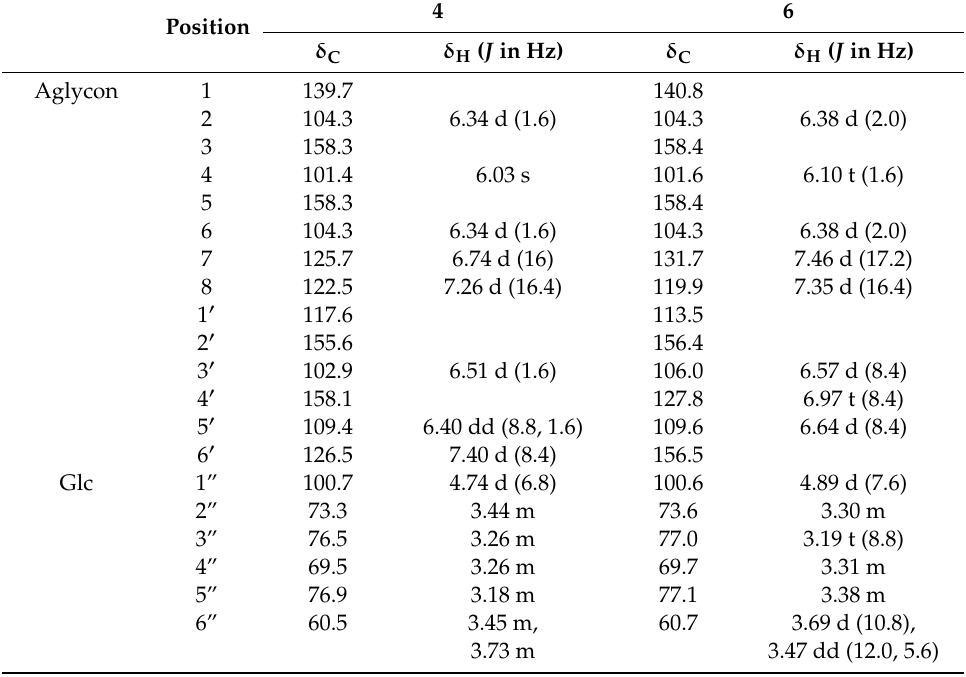
Table 1. 1 H and 13 C-NMR data of oxyresveratrol 2 (cid:48) - β -glucoside ( 4 ) and gnetol 2 (cid:48) - β -glucoside ( 6 ).